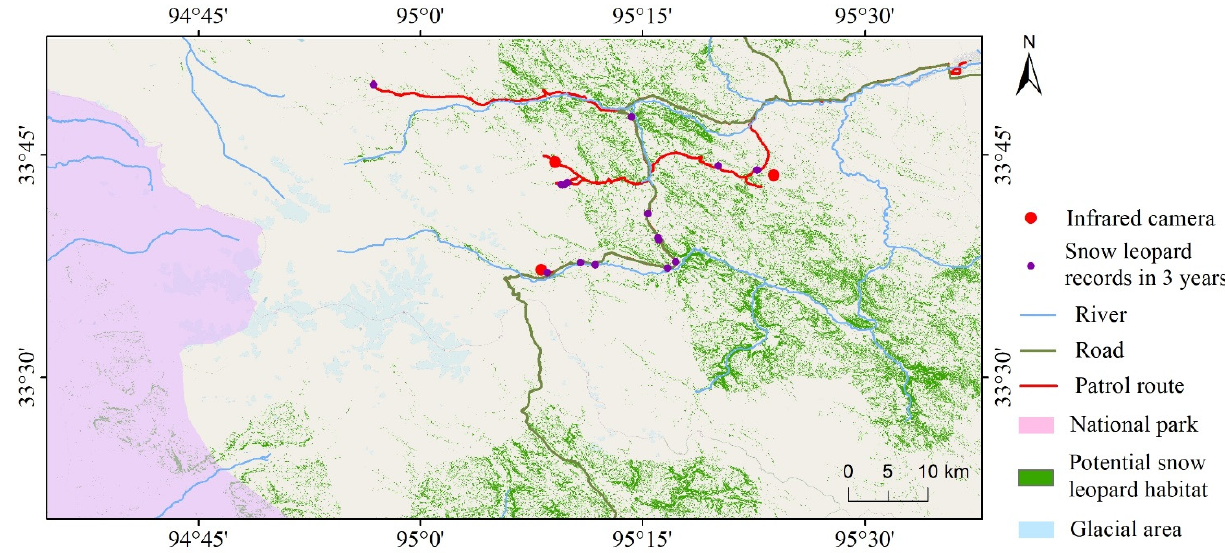
Figure 3. The main potential snow leopard habitats in Sobchaye.